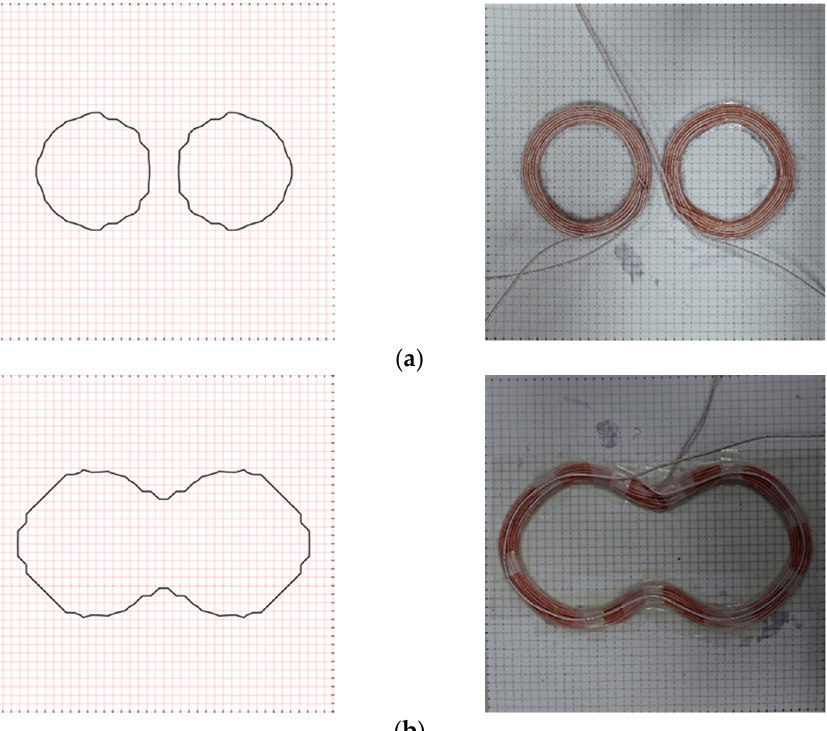
Figure 4. Optimized transmitter coil according to the air gap of 10 mm and 30 mm (the left and right columns show the transmitter coil optimized by the proposed method and transmitter coils fabricated for experiments, respectively). In the case of the 10 mm air gap, the optimized transmitter coil is a single transmitter coil connected in series, although the number of the topology for the transmitter coil made by the proposed method is two. ( a ) Air gap of 10 mm; ( b ) Air gap of 30 mm.